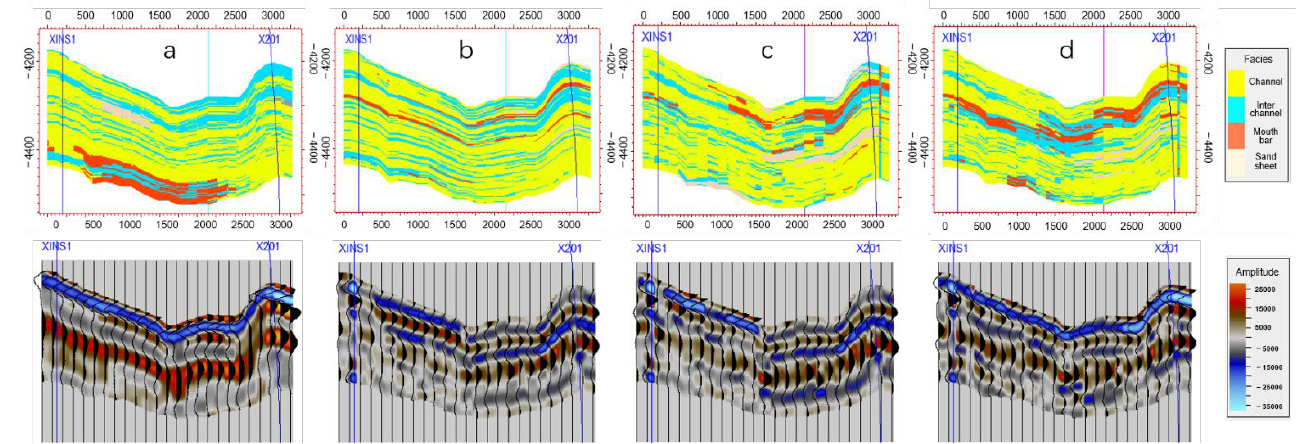
Figure 16. Inversion of the lithofacies model and synthetic seismic record through wells xins1 – X201 for the training image and the different methods: ( a ) Training image, ( b ) TPI model, ( c ) MPI model, and ( d ) LPUMI model.